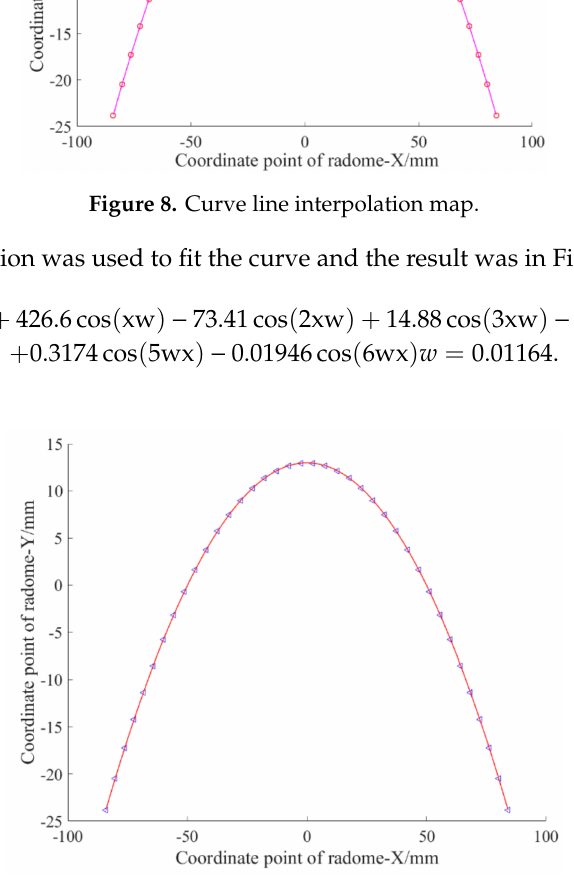
Figure 9. Fourier form fitting curve for the target